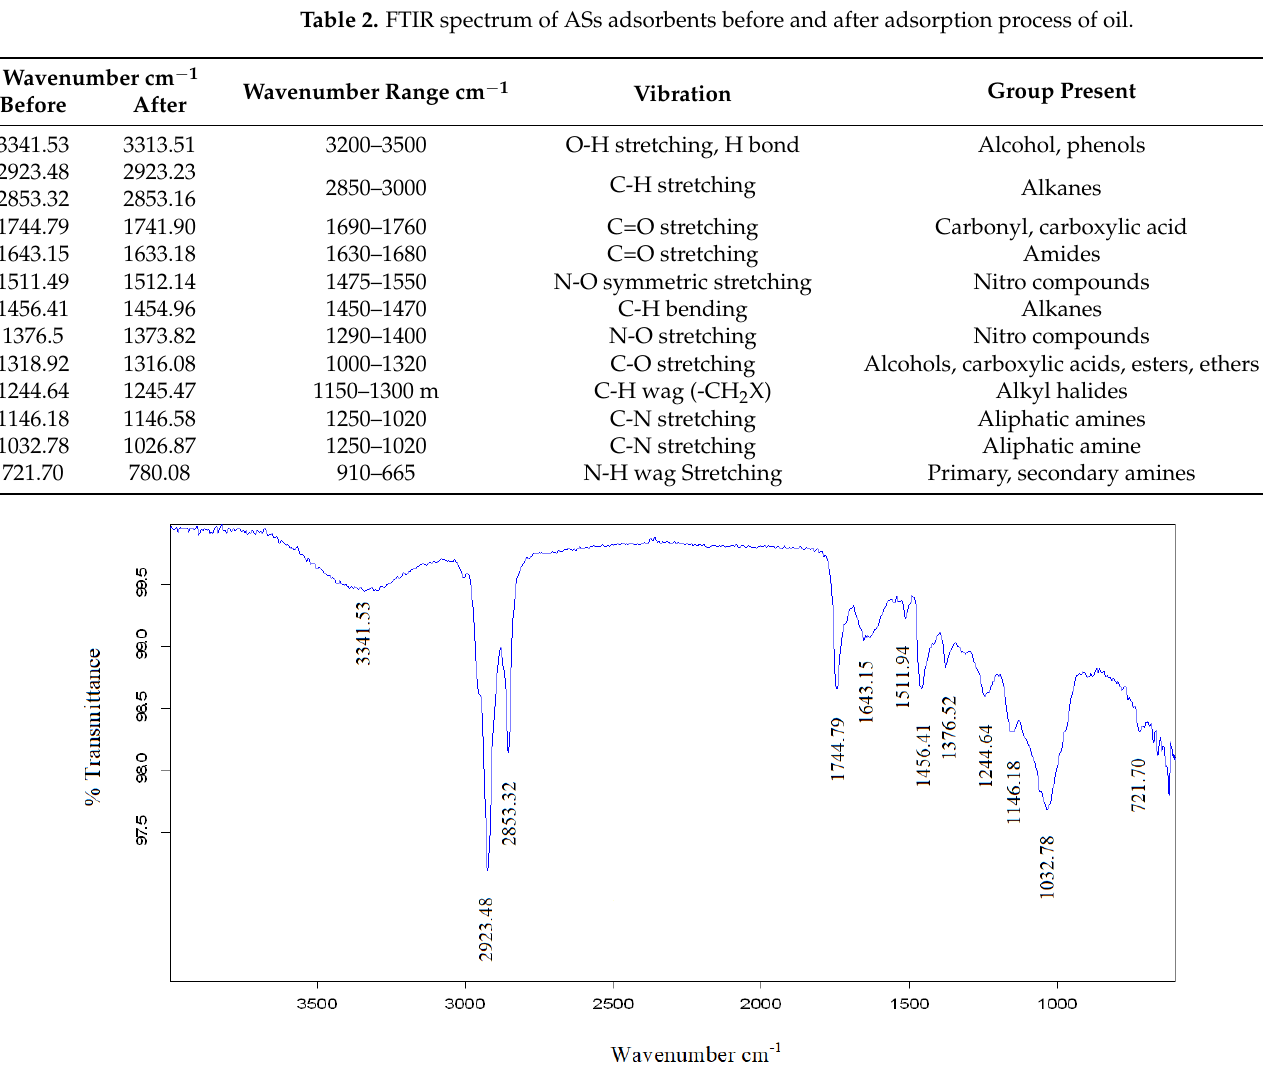
Figure 5. FTIR spectrum for AR adsorbents before adsorption of oil.